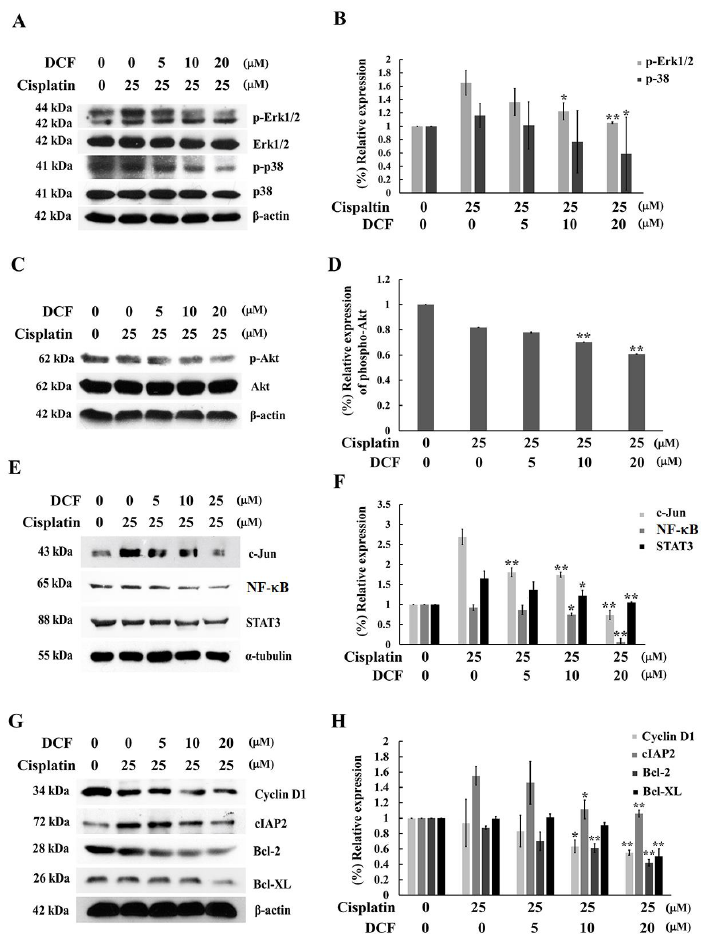
Figure 5. DCF downregulated survival proteins and modulated survival signaling pathways in KATO/DDP cells. The cells were treated with either cisplatin alone or in combination with DCF at 5, 10 or 20 μM. After incubation for 24 h, the whole cell lysate was prepared and subjected to inves- tigate the activation of Erk1/2 and p38 MAPKs ( A ) and Akt ( C ) signaling molecules by Western blot analysis. Densitometric and statistical analysis were performed to determine the relative phosphor- ylation of Erk1/2, p38 ( B ) and Akt ( D ). The nucleus extraction was used to analyze the transcrip- tional activity of c-Jun, NF- κ B and STAT3 ( E ) and histogram graph represented the band intensity of c-Jun, NF- κ B and STAT3 ( F ). The expression levels of survival and proliferation proteins includ- ing cyclinD1, cIAP2, Bcl-2 and Bcl-XL were examined by Western blot analysis ( G ), and the histo- gram represented the band intensity of survival proteins ( H ). All experiments were performed at least three times. * Represented p < 0.05, while ** represented p < 0.01 as compared to the cisplatin alone. DCF = Diclofenac.